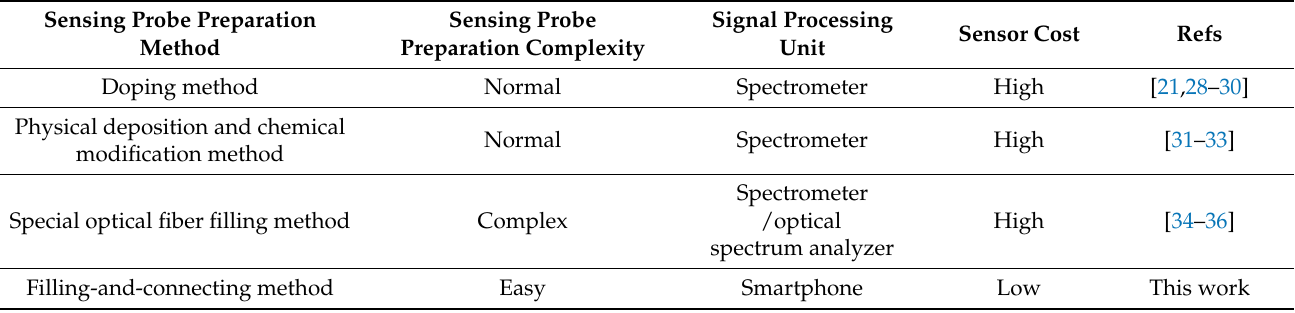
Table 1. Comparison of different optical fiber fluorescence temperature